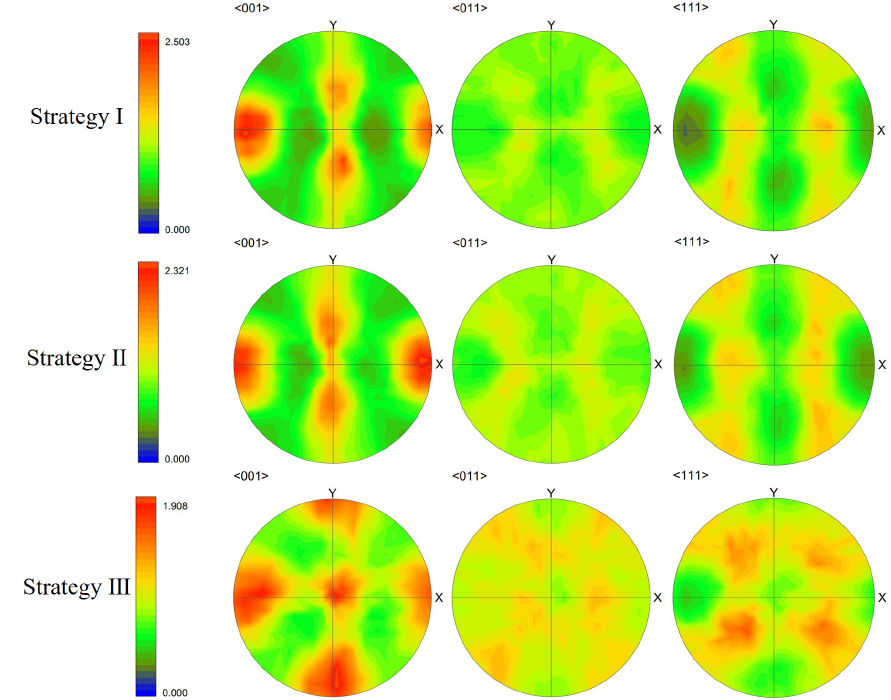
Figure 22. Pole figures (PF) of solidification grain structure within the fusion zone of Strategy I, Strategy II, and Strategy III simulation